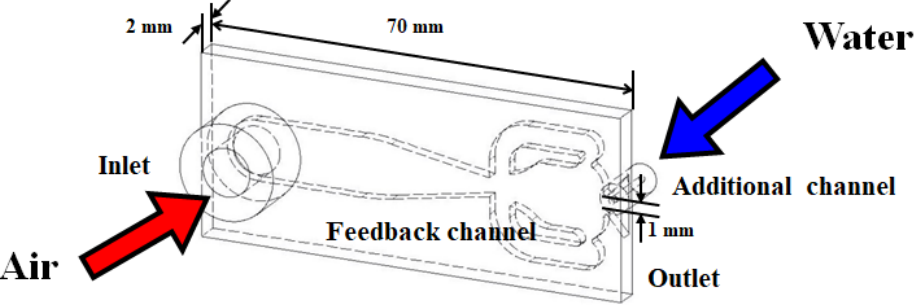
Figure 2. Structure of the proposed nozzle.